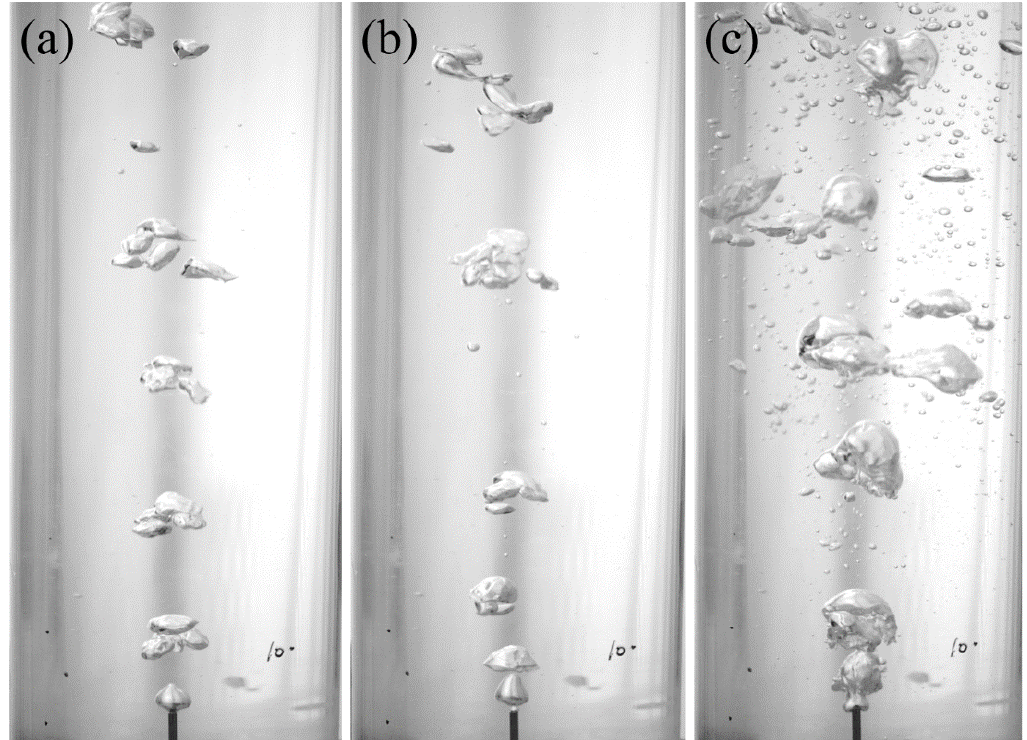
Figure 9. Still frames in the D = 102 mm column with d inj = 1.6 mm with an injection condition of ( a ) P m = 260 kPa, U sg = 3.5 mm/s; ( b ) P m = 600 kPa, U sg = 6.9 mm/s and ( c ) P m = 40 kPa, U sg = 11.1 mm/s.